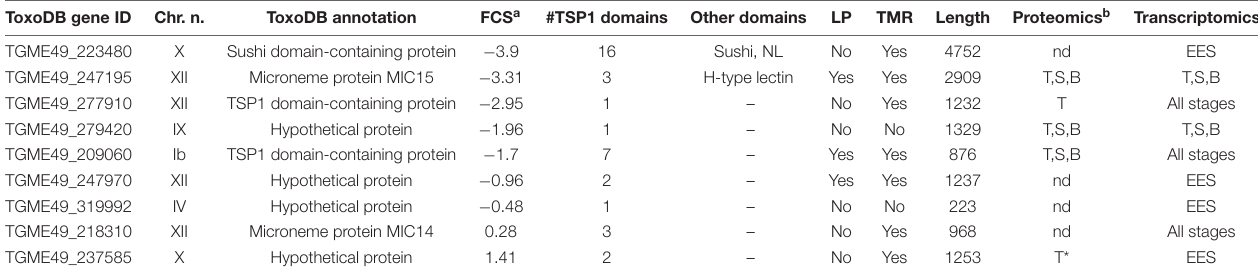
TABLE 1 | Uncharacterized thrombospondin-related proteins in Toxoplasma gondii. ToxoDB gene ID Chr.